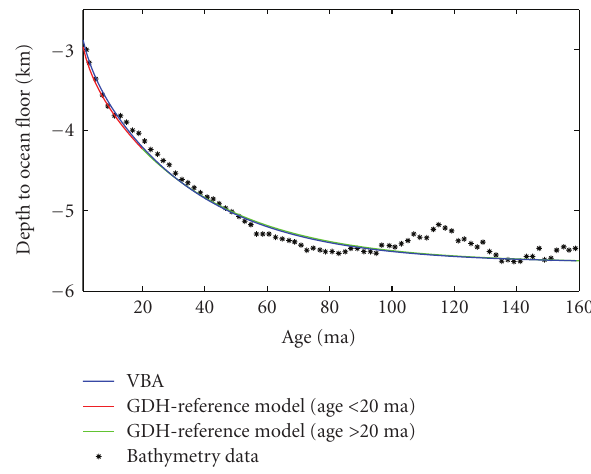
Figure 8: Comparison of the fits of VBA and GDH reference models to bathymetry data. Note that VBA model curve (in blue color) of the present work provides a remarkably good fit for the entire age range of the oceanic lithosphere. The GDH model [36] requires two separate curves (red and green curves), for arbitrarily selected age intervals, in achieving an equivalent